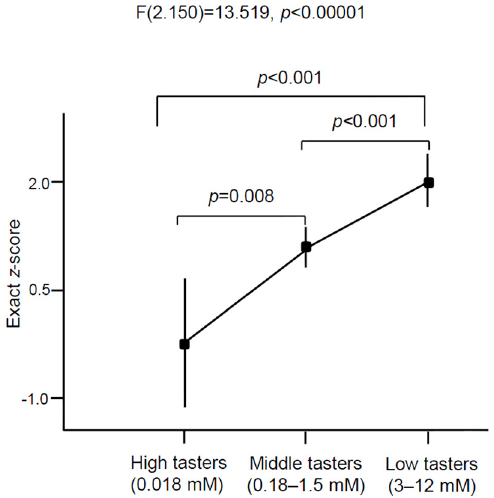
Figure 2. Fatty acid sensitivity in all young teenagers in relation to BMI. The lean and obese children ( n = 165) were divided into three groups on the basis of oro ‐ sensory detection of oleic acid as high, middle, and low tasters. “High tasters” group contained lean teenagers only ( n = 8), most of the teenagers from the both groups (control, n = 60; obese, n = 45) belonged to the “Middle tasters” group and the “Low tasters” group consisted predominantly of obese participants ( n = 41) and controls ( n = 11). The results are means ± SEM.